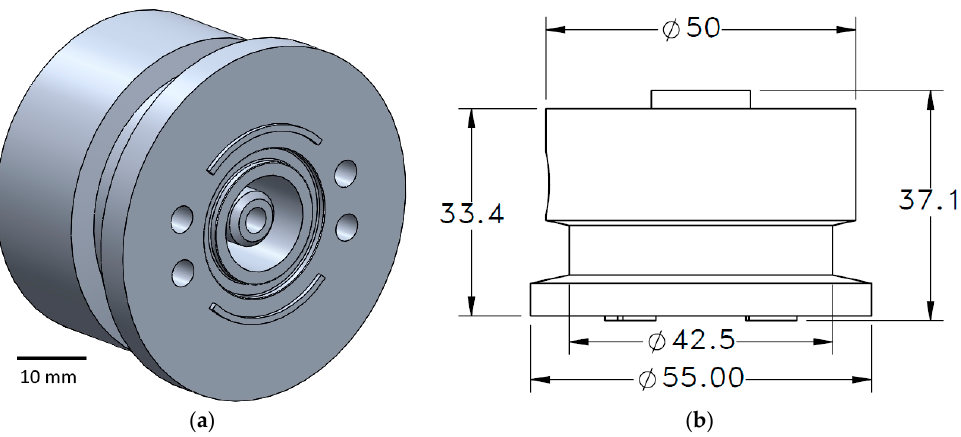
Figure 3. ( a ) Water port (inner face), showing the water-cooling channel in the center, circular segments for target plate centering and the four holes housing the anchor studs with springs and release pins. ( b ) Water port (side view), dimensions in mm. ( b ) Water port (side view), dimensions in